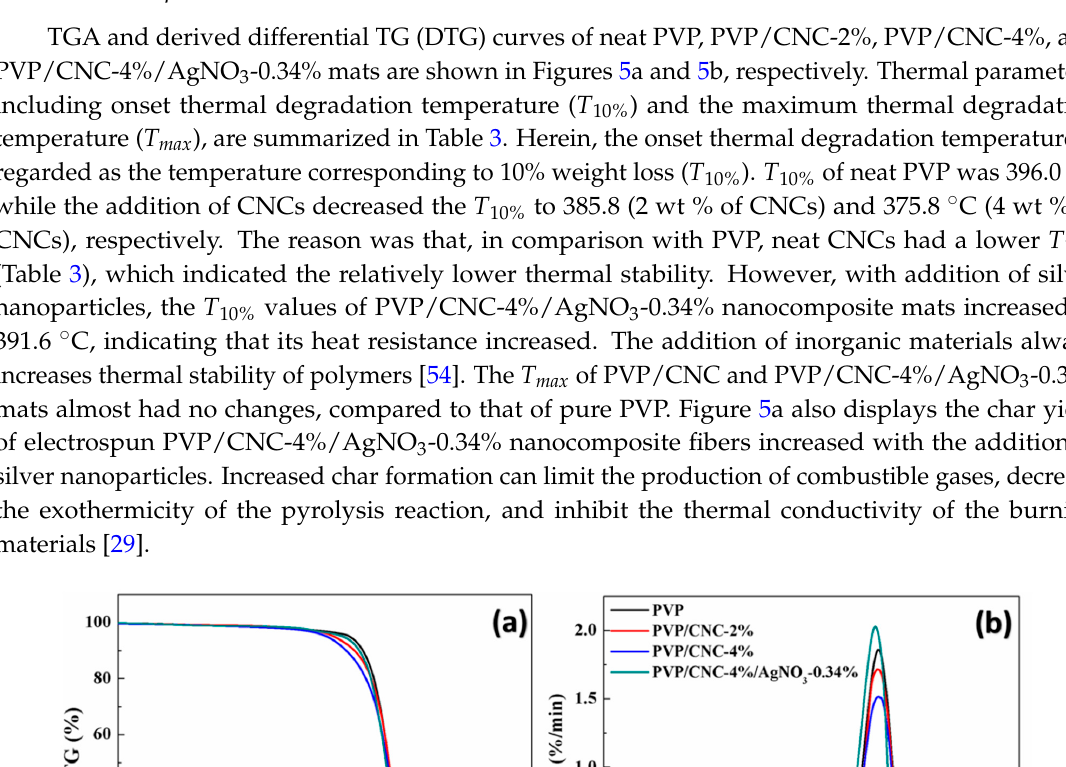
Figure 4. FTIR spectra of: ( a ) PVP; ( b ) PVP/CNC-4%; ( c ) PVP/AgNO 3 -0.34%; and ( d ) PVP/CNC- 4%/AgNO 3 -0.34%.